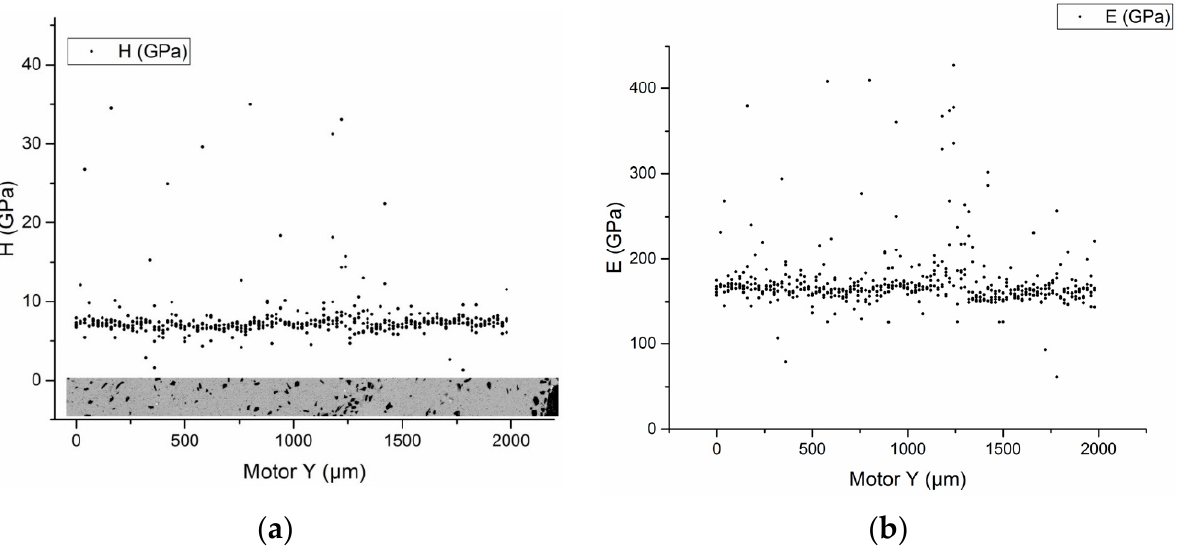
Figure 8. Dependence of hardness ( a ) and elastic modulus ( b ) on the place of measurement for the sample Ti64 + SiC powder.